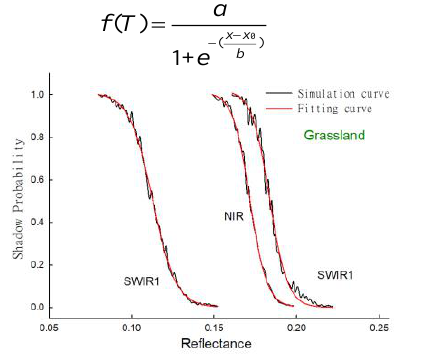
Figure 2. Fitting curves for